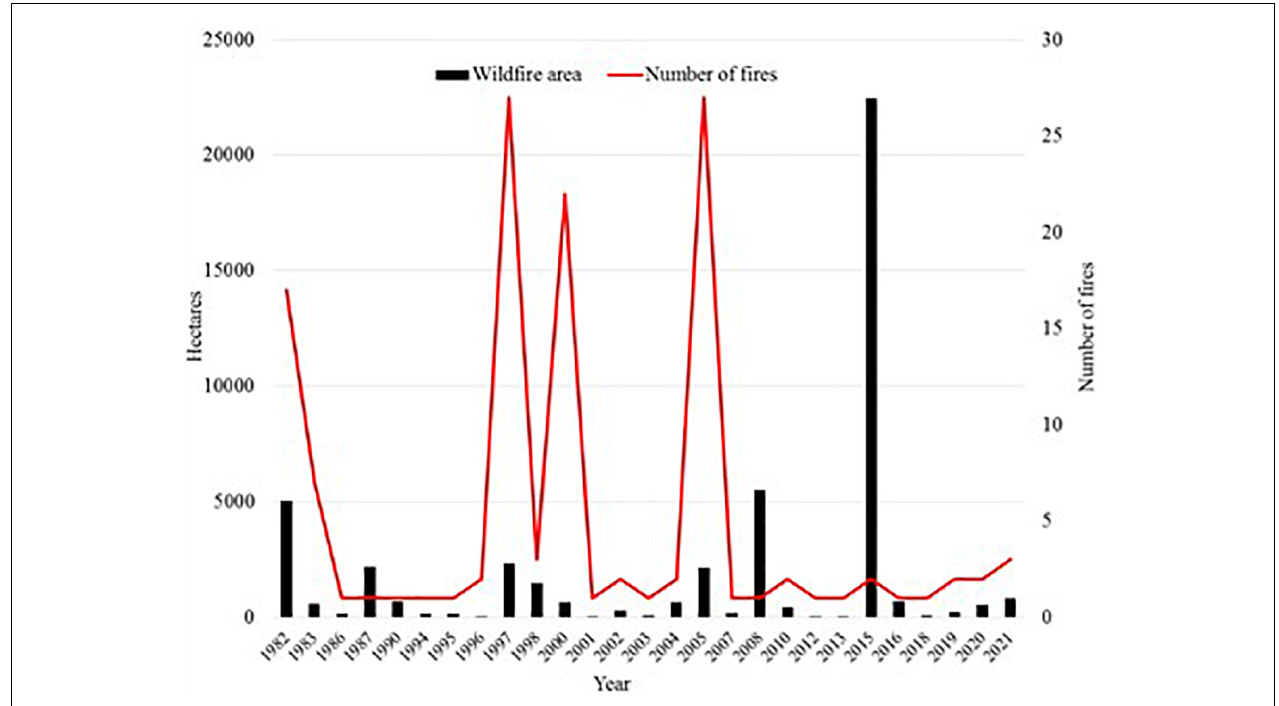
FIGURE 7 | Number and area of wildfires in the study area. In 2015 a few ignitions burned more than 20,000 ha.